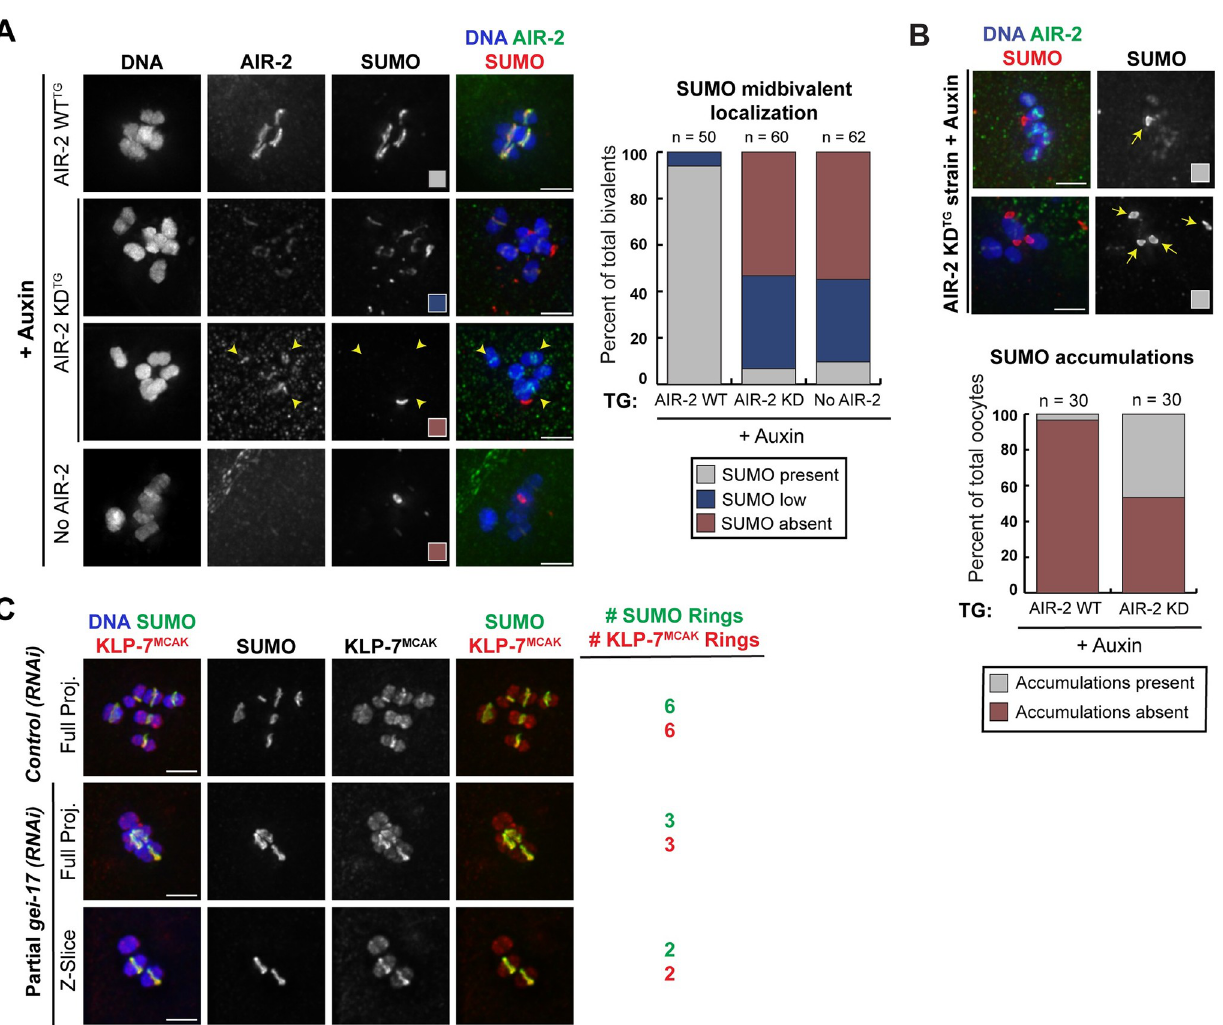
Fig 4. Aurora B kinase activity is required for SUMO-dependent ring complex assembly. (A) SUMO (red) in oocytes expressing transgenic wild-type AIR-2 (top row), kinase-dead AIR-2 (middle two rows) and no AIR-2 (bottom row); all images are in the presence of auxin to degrade endogenous AIR-2, so the AIR-2 antibody (green) denotes the localization of transgenic AIR-2. SUMO localizes to the midbivalent when wild-type transgenic AIR-2 is expressed, but in the presence of kinase-dead AIR-2, SUMO was only weakly associated with chromosomes or entirely absent; arrowheads show examples of chromosomes where kinase-dead AIR-2 was chromosome-associated, but SUMO was not present. In the no AIR-2 condition, SUMO was entirely absent from chromosomes. Note that the SUMO signals in the bottom two rows appear chromosome-associated in the full projection images, but are not in the same focal planes as the chromosomes and therefore are likely to be SUMO accumulations, analogous to those shown in panel B. Quantification to the right of the images. (B) In the absence of AIR-2 kinase activity, many oocytes displayed accumulations of SUMO (red, highlighted with arrows) that did not appear to be associated with the chromosomes. Quantification shown below the images. (C) KLP-7 MCAK localization to the RC is dependent on SUMOylation. In control oocytes, all six RCs are SUMOylated (green) and KLP-7 MCAK (red) localizes to all six bivalents (blue). After 36 hours of gei-17 (RNAi) (partial depletion), only 3 RCs were SUMOylated and KLP-7 MCAK localized only to those 3 RCs; bottom image shows a single z-slice to highlight KLP-7 MCAK localization more clearly. Bars = 2.5 μ